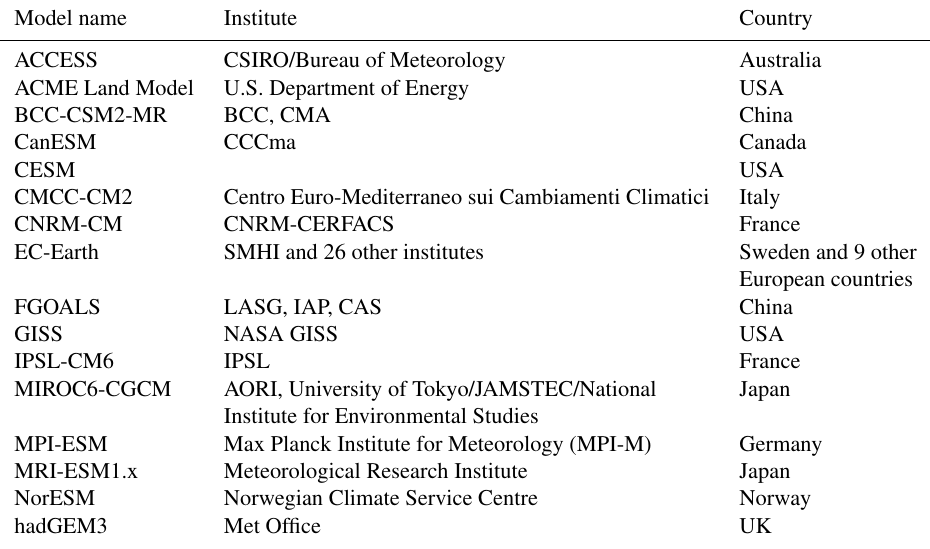
Table 2. Earth system modeling groups participating in